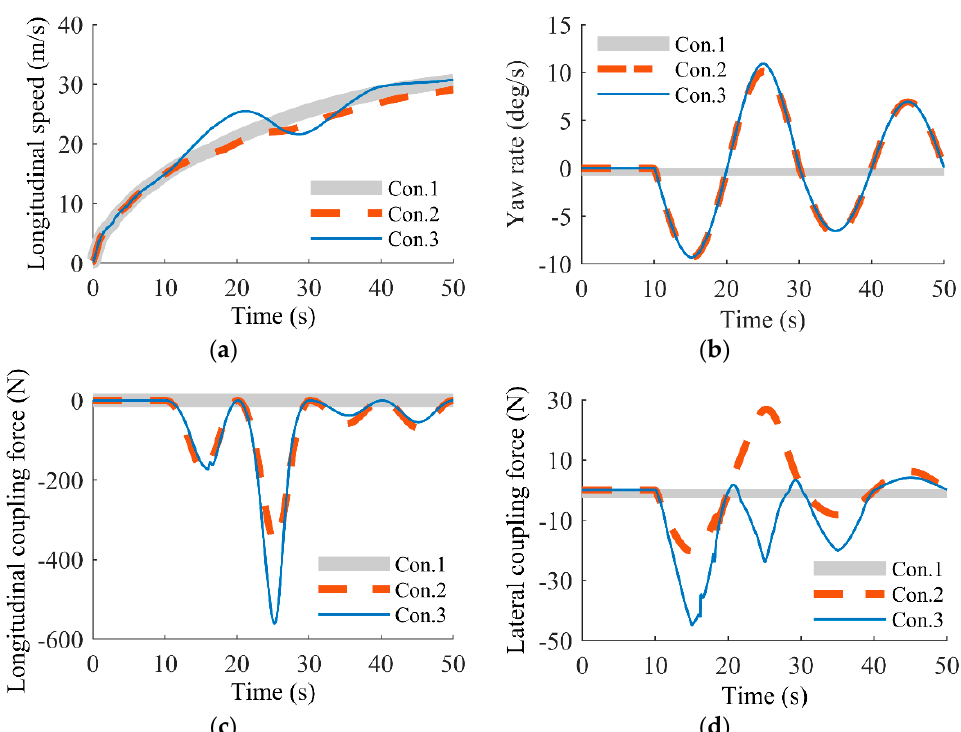
Figure 6 . Comparative simulation results: ( a ) longitudinal speed; ( b ) yaw rate; ( c ) coupling force in longitudinal direction; ( d ) coupling force in lateral direction.